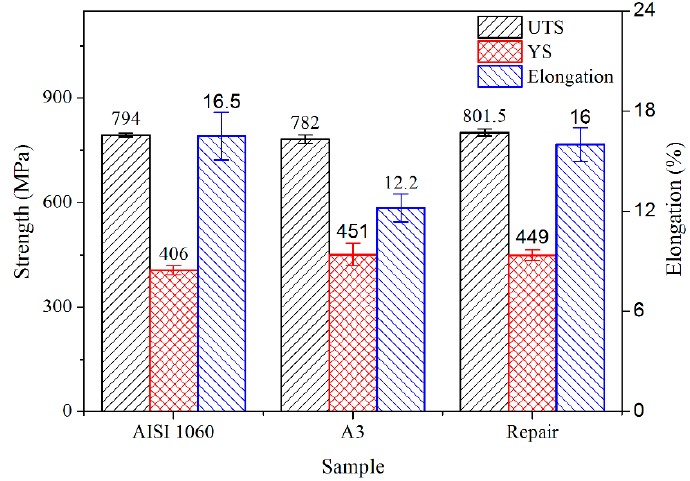
Figure 13. Comparison of the mechanical properties of the AISI 1060, 410L + 12.5% Fe–Cr–B–Si–Mo, and repair samples.